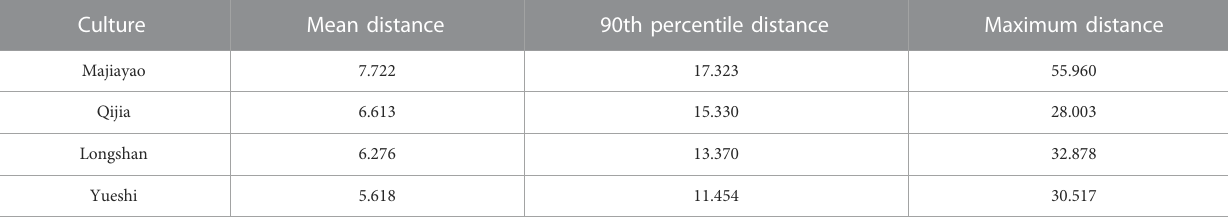
TABLE4Statisticsof thedistance(km) between thearchaeologicalsite andthewater body (including riversandlakes)fordifferentcultures.Note:the sitesonthe islands were excluded.